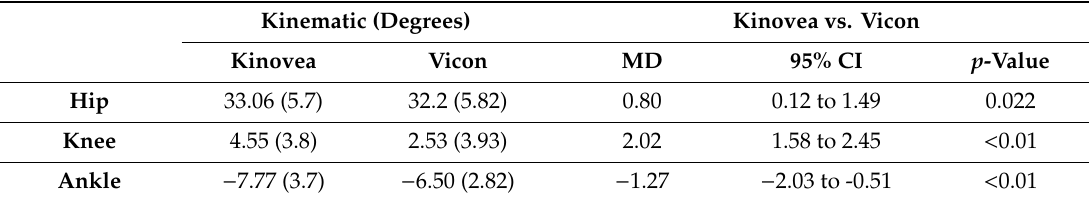
Table 3. Validity of the Kinovea parameters.